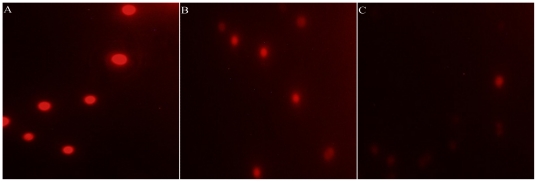
The observation of Chl a fluorescence intensity after H2O2 exposure.A: Control; B: L0 treatment; C: D0 treatment.